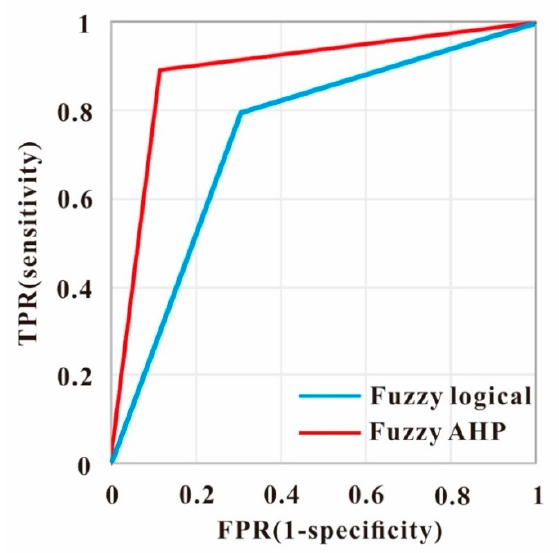
Figure 10. Verification of ROC curve. Table 8. Statistical results of the two methods.